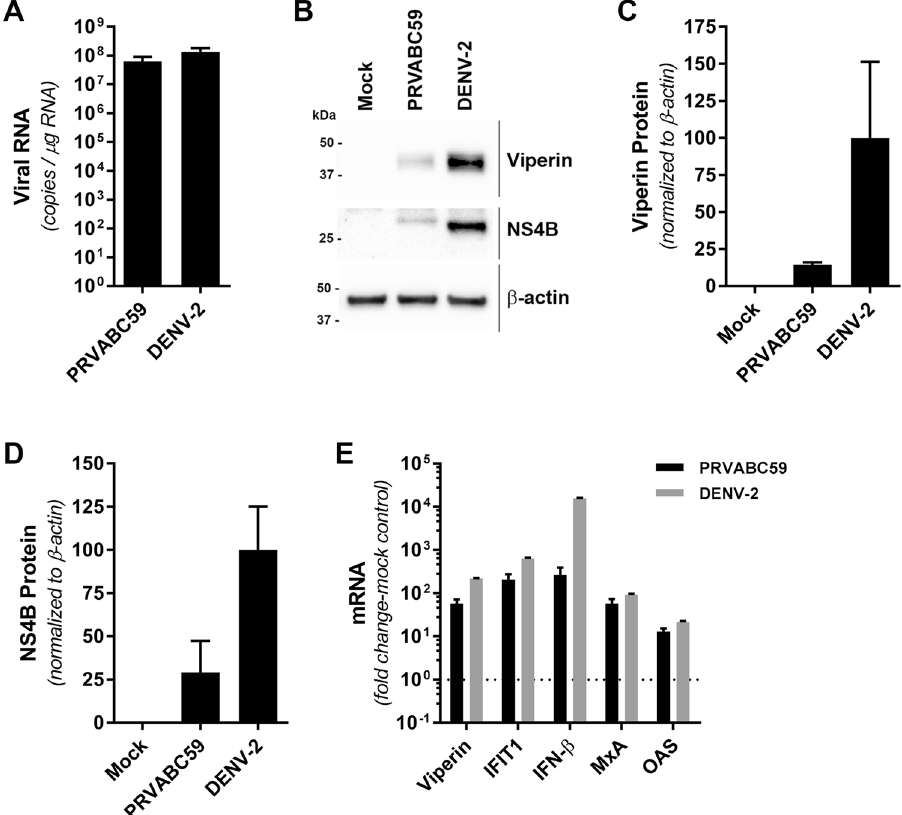
Figure 4. Human monocyte-derived macrophages are moderately susceptible and responsive to ZIKV infection. Human monocyte-derived macrophages were infected with ZIKV (PRVABC59) or DENV-2 (Mon601) for 48 h (MOI = 1) prior to analysis of viral replication and ISG expression by qRT-PCR and Western blotting in parallel. ( A ) ZIKV and DENV-2 RNA levels were determined by qRT-PCR using plasmid DNA standard curves. Data are expressed as viral RNA copy numbers per μ g of total cell RNA (means + SD, n = 3). ( B ) Parallel cultures were subjected to immunoblotting analysis of viperin and NS4B expression, with β -actin serving as a loading control. ( C , D ) Quantitation of Viperin and NS4B protein levels, normalized to β -actin (means + SD, n = 3). ( E ) ISG mRNA levels were determined by qRT-PCR. Data are normalised to the RPLPO housekeeping gene and expressed as a fold-change relative to mock-infected controls (means + SD, n =